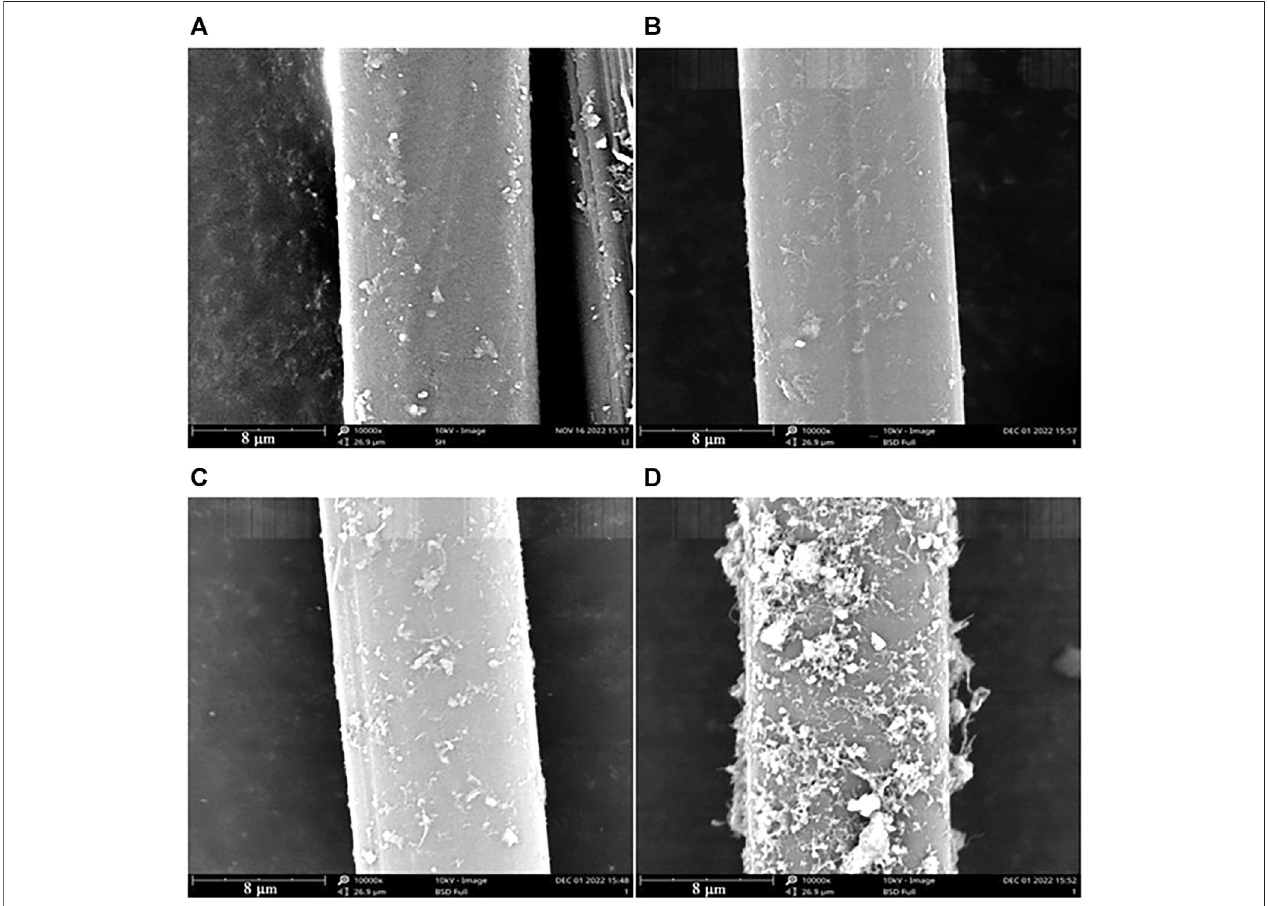
FIGURE 2 | Surface morphology of modi fi ed aramid fi ber with different concentrations of CNT added: (A) AF-PDA-0.01% CNT, (B) AF-PDA-0.03% CNT, (C) AF- PDA-0.05% CNT, (D) AF-PDA-0.1% CNT.